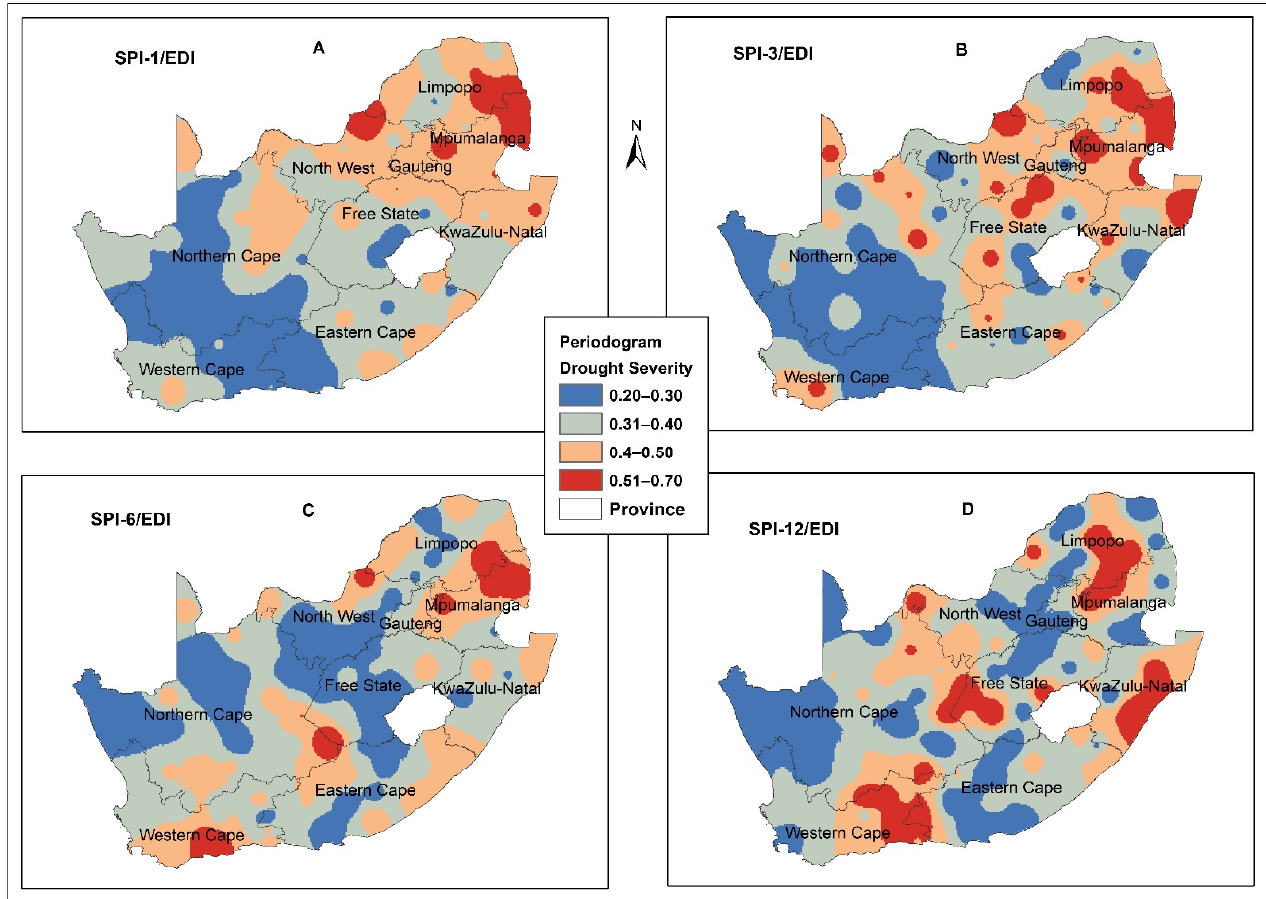
Figure 9. Periodogram dissimilarity measure for drought severity in South Africa. ( A ) SPI-1/EDI; ( B ) SPI-3/EDI; ( C ) SPI- 6/EDI; and ( D ) SPI-12/EDI.